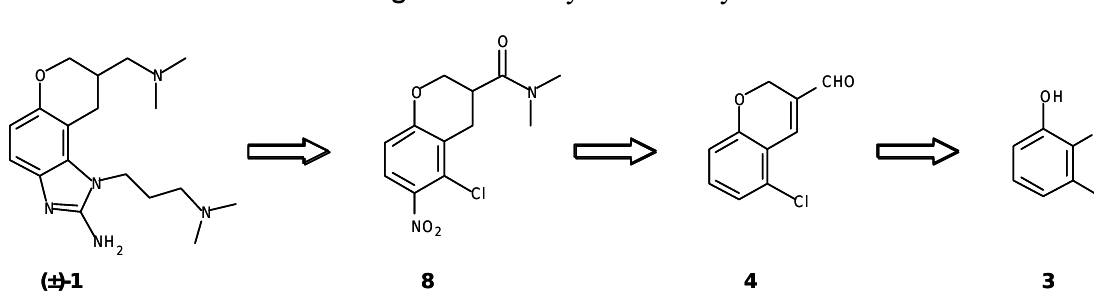
Figure 2. Retrosynthetic analysis.